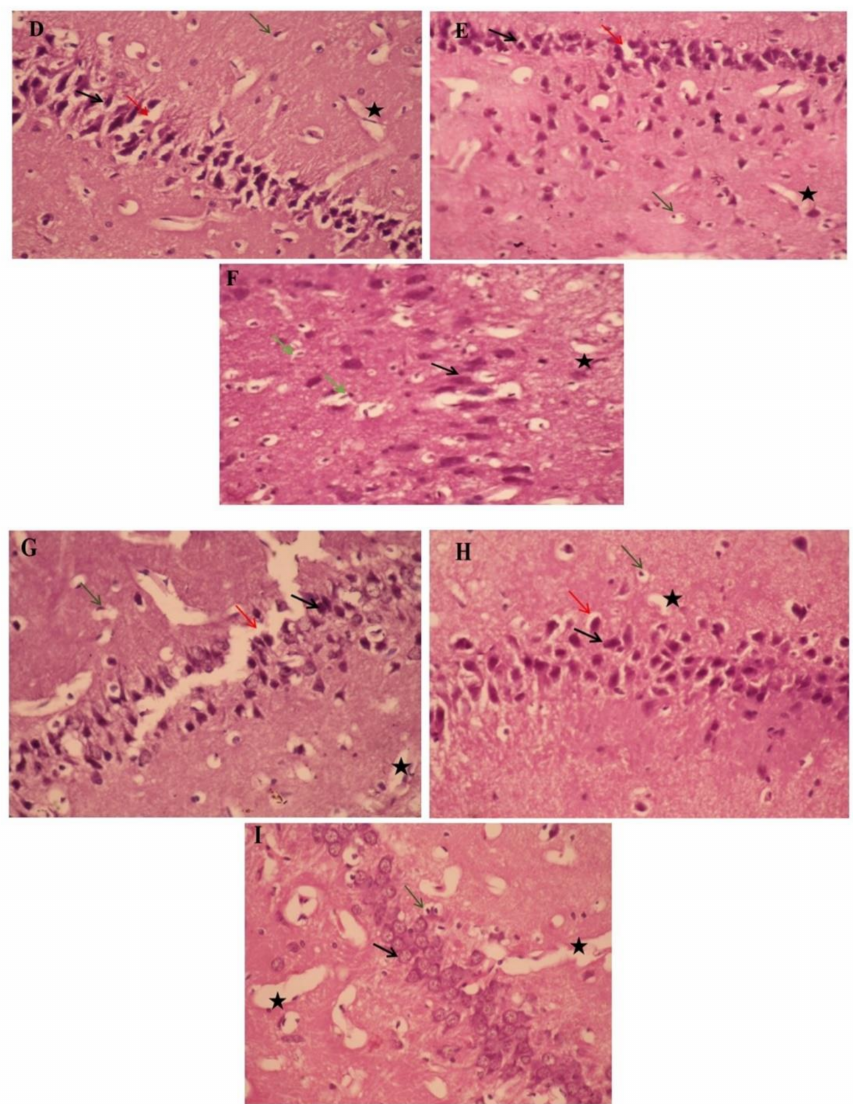
Figure 6. The effects of ZnONP and CurNP on the histology of hippocampi in rat groups. Hip- pocampi of rats were evaluated via hematoxylin-eosin (H&E) staining at 400 X magnification. ( A ) The control group: a photomicrograph of the hippocampus showing arranged pyramidal cells (black arrows) with minimum vacuolated cytoplasm (Red arrows), a few pyknotic neuropil cells (Green arrows), and homogenous brain tissue (black asterisk). ( B ) Untreated HFD/STZ-induced group: a photomicrograph of the hippocampus showing marked proliferating pyramidal cells with dark nuclei (black arrows) with minimum vacuolated cytoplasm (red arrows) and many pyknotic neuropile cells (green arrows), and reduction of the myelinated sheath (black asterisk). ( C ) HFD/STZ-induced rats treated with curcumin: a photomicrograph of the hippocampus showing some pyramidal cells with hyperchromatic nuclei (black arrows) and marked vacuolated cytoplasm (red arrows) and many neuropile cells (green arrows), with mildly dilated and hemorrhaged blood capillaries (black asterisk). ( D ) HFD/STZ-induced rats treated with CurNP-10: a photomicrograph of the hippocampus showing normal features of many neuropil cells and few pyknotic ones (green arrows), mildly proliferating pyramidal cells with hyperchromatic nuclei (black arrows) and mildly vacuolated cytoplasm (red arrows) with homogenous brain tissue (black asterisk). ( E ) HFD/STZ- induced rats treated with CurNP-50: a photomicrograph of the hippocampus showing pyramidal cells having dark pyramidal nuclei (black arrows) and mildly vacuolated cytoplasm (red arrows) with few necrotic ones (green arrows) and homogenous brain tissue (black asterisk). ( F )